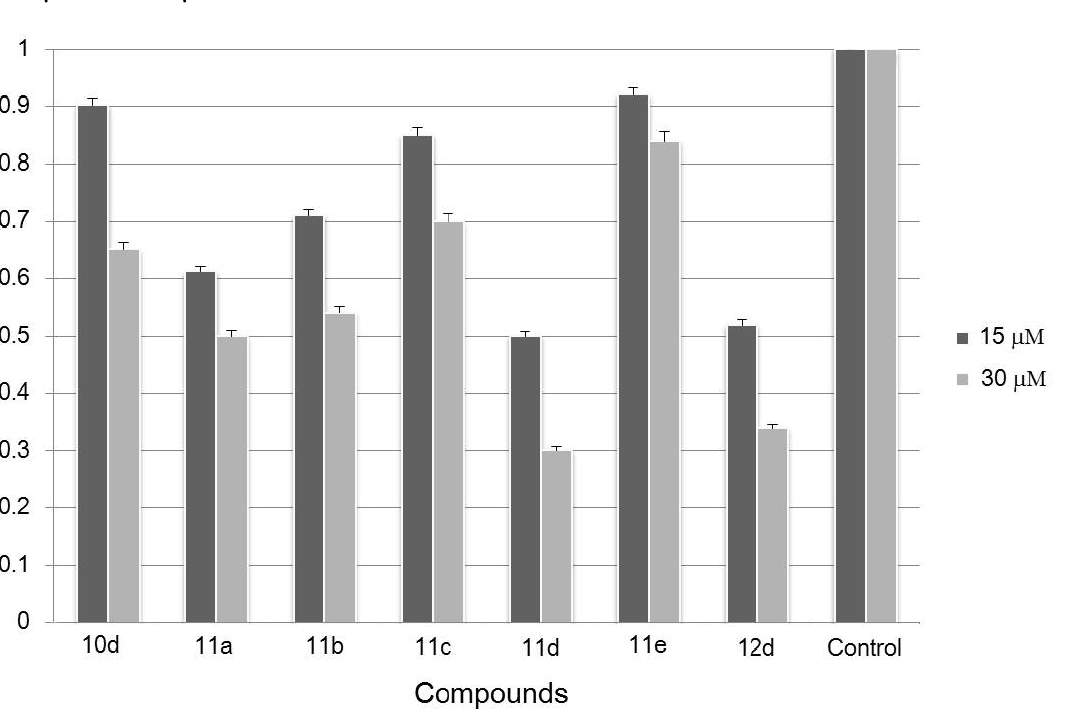
Figure 2. The inhibitory effects of quinazoline derivatives on HUVEC migration at doses of 15 μ M and 30 μ